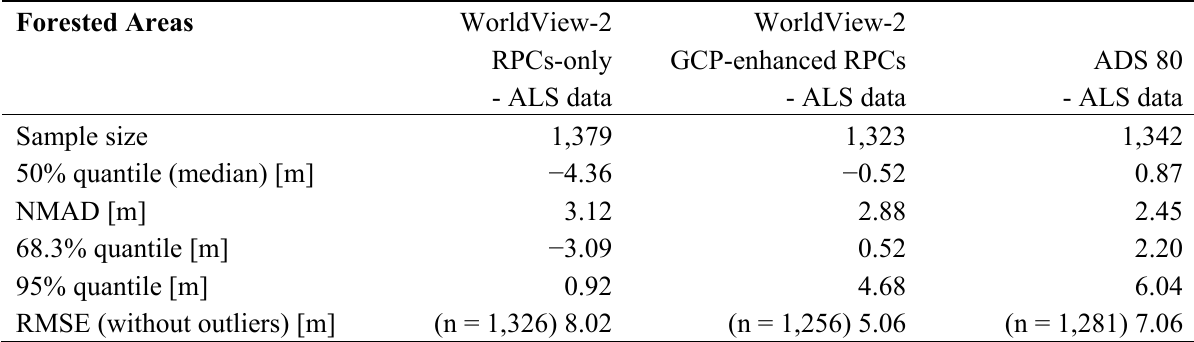
Table 8. Forested areas. Vertical accuracy measures of the three digital surface models in comparison with the airborne laser data.